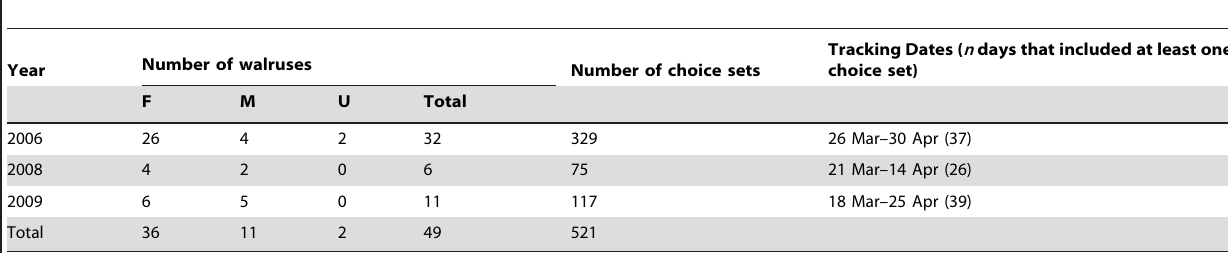
Table 1. Radio-tags attached to Pacific walruses to derive choice sets of available macroinfauna and sea ice concentrations to model resource selection in 2006, 2008, and 2009 in the northern Bering Sea.